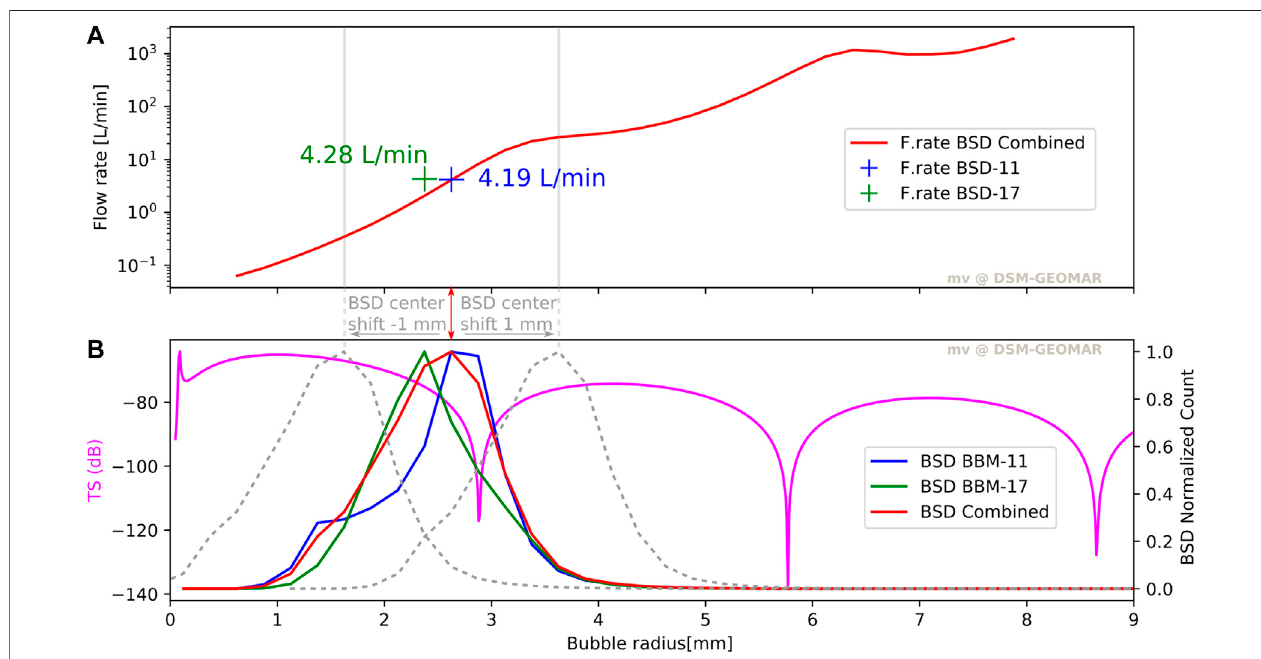
FIGURE12| SensitivityoftheinversemethodtoBSD. (A) FlowratesusingaBSDshiftedbysizeobtainedwith Eq.11 foraconstantamplitudevalue A bsT =53 dB. The calculation used the combined BSD obtained from BBox observations ( Figure 5A ). The fi gure also depicts the results of the fl ow rate based on BBM-11 and BBM- 17 bubble size distribution (4.19 and 4.28 L/min, respectively). (B) Theoretical acoustical backscattering response of single spherical bubble versus bubble radius and BSDs from deployments BBM-11 and BBM-17 and their